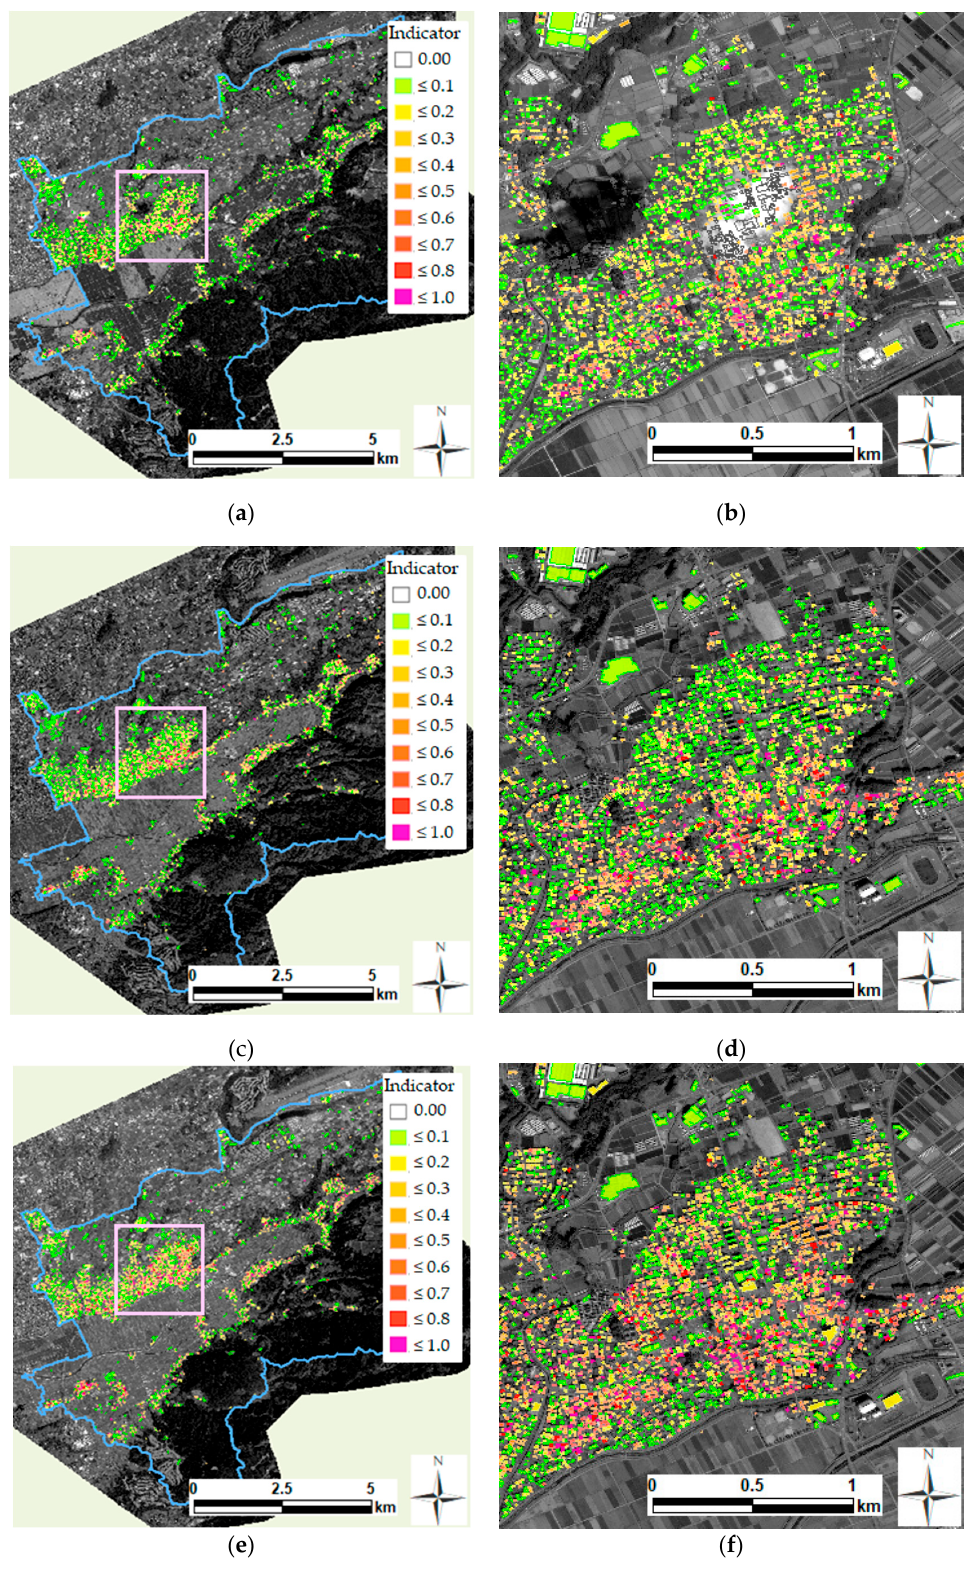
Figure 12. Indicator distribution map: ( a ) Result from 20 March 2016 SPOT image; ( c ) result from 1 January 2017 SPOT image; ( e ) result from 25 March 2018 SPOT image; and ( b , d , f ) zoomed-in views of the rectangle area for each result.